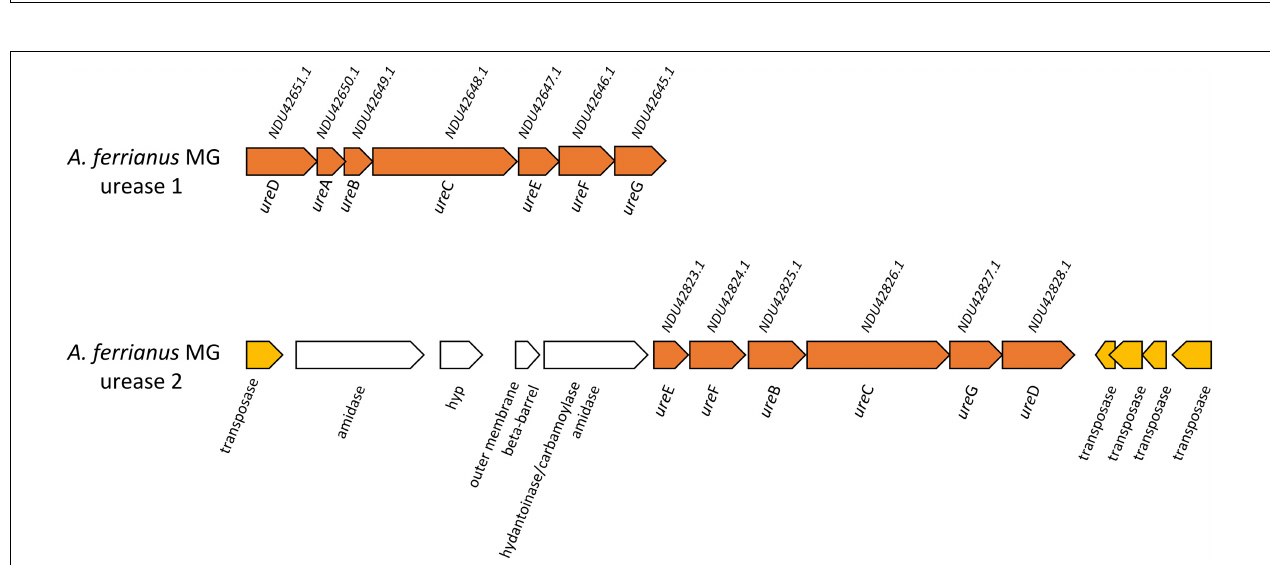
FIGURE 8 | Genetic organization of urease 1 and urease 2 system in A. ferrianus MG. Genome context of urease 1 and extended urease 2 in A. ferrianus MG formed by ure ABCDEFG (orange) with their corresponding accession numbers. Mobile genetic elements are highlighted by yellow arrows.